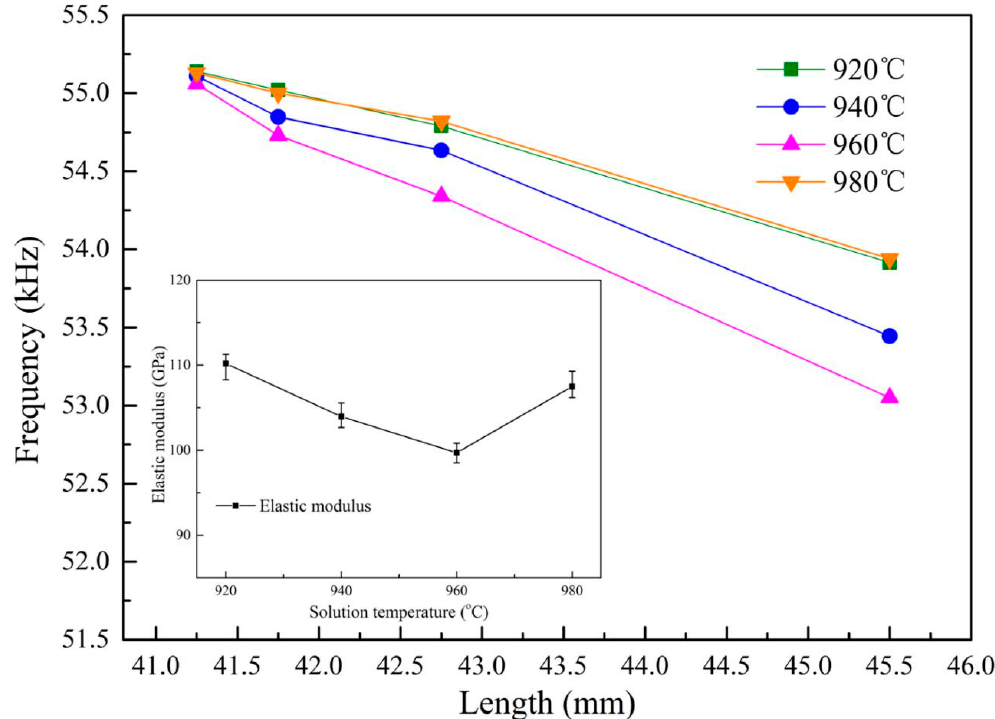
Figure 4. Dependence of the resonant frequency on the solid solution temperature and the sample length of Ti6Al4V alloy vibrator.